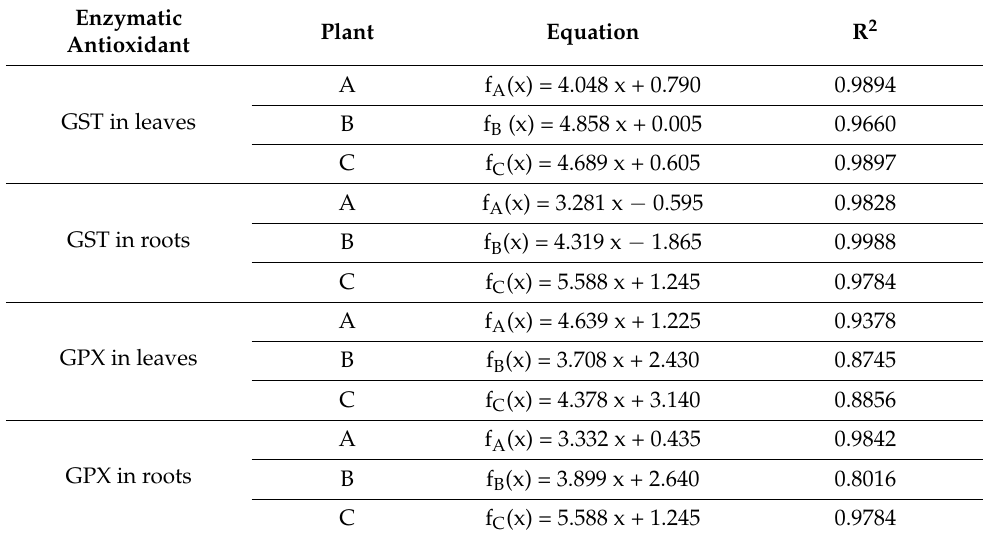
Table 1. The equations and correlation coefficients for the model describing changes in enzymes